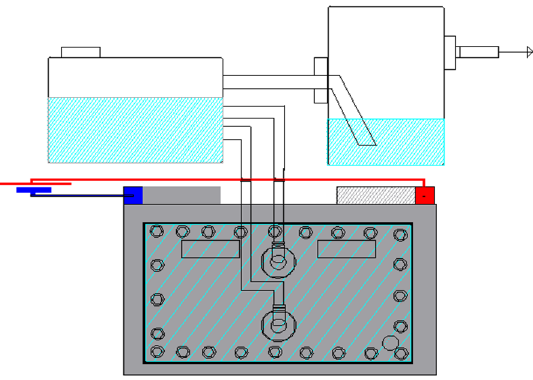
Figure 5. Schematic of the entire system (Own study).